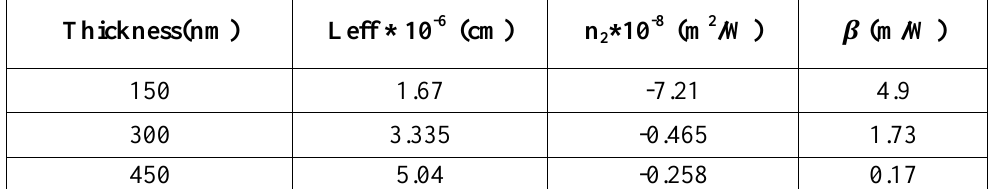
Fig.10: a, b, and c; the curves (open-aperture Z- scan) of the CuPc thin films at different thickness. Table 3: Illustrate measured values of effective length, non-linear refractive index and non-linear absorption coefficient for different thicknesses thin films of